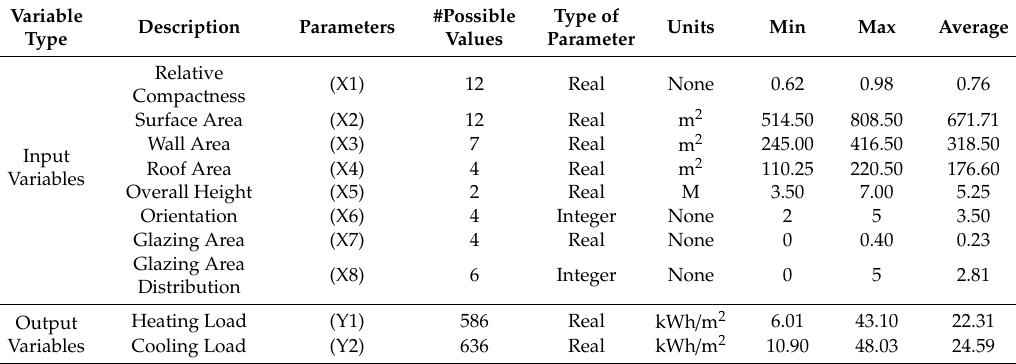
Table 2. Description of the energy performance buildings (EPB)